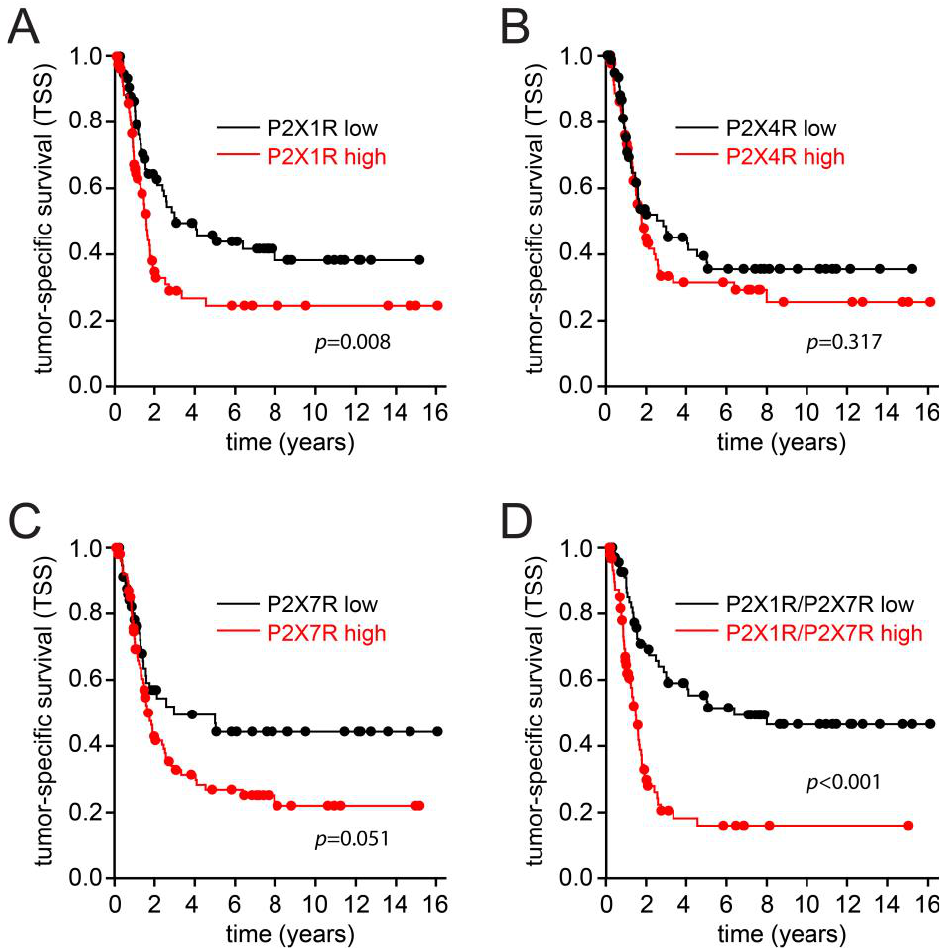
Figure 4. Effect of P2X receptor expression levels on tumor-specific survival (TSS) in muscle-invasive bladder cancer (MIBC). Expression of P2X1R ( A ), P2X4R ( B ), P2X7R ( C ), and combined expression of P2X1R and P2X7R ( D ) was immunohistochemically analyzed in MIBC and scored as “low” (below median) or “high” (above median). Kaplan–Meier tumor-specific survival (TSS) curves were plotted, and groups were compared by the log-rank test; ( A , B ): n = 171; ( C ): n = 172; ( D ): n = 170.